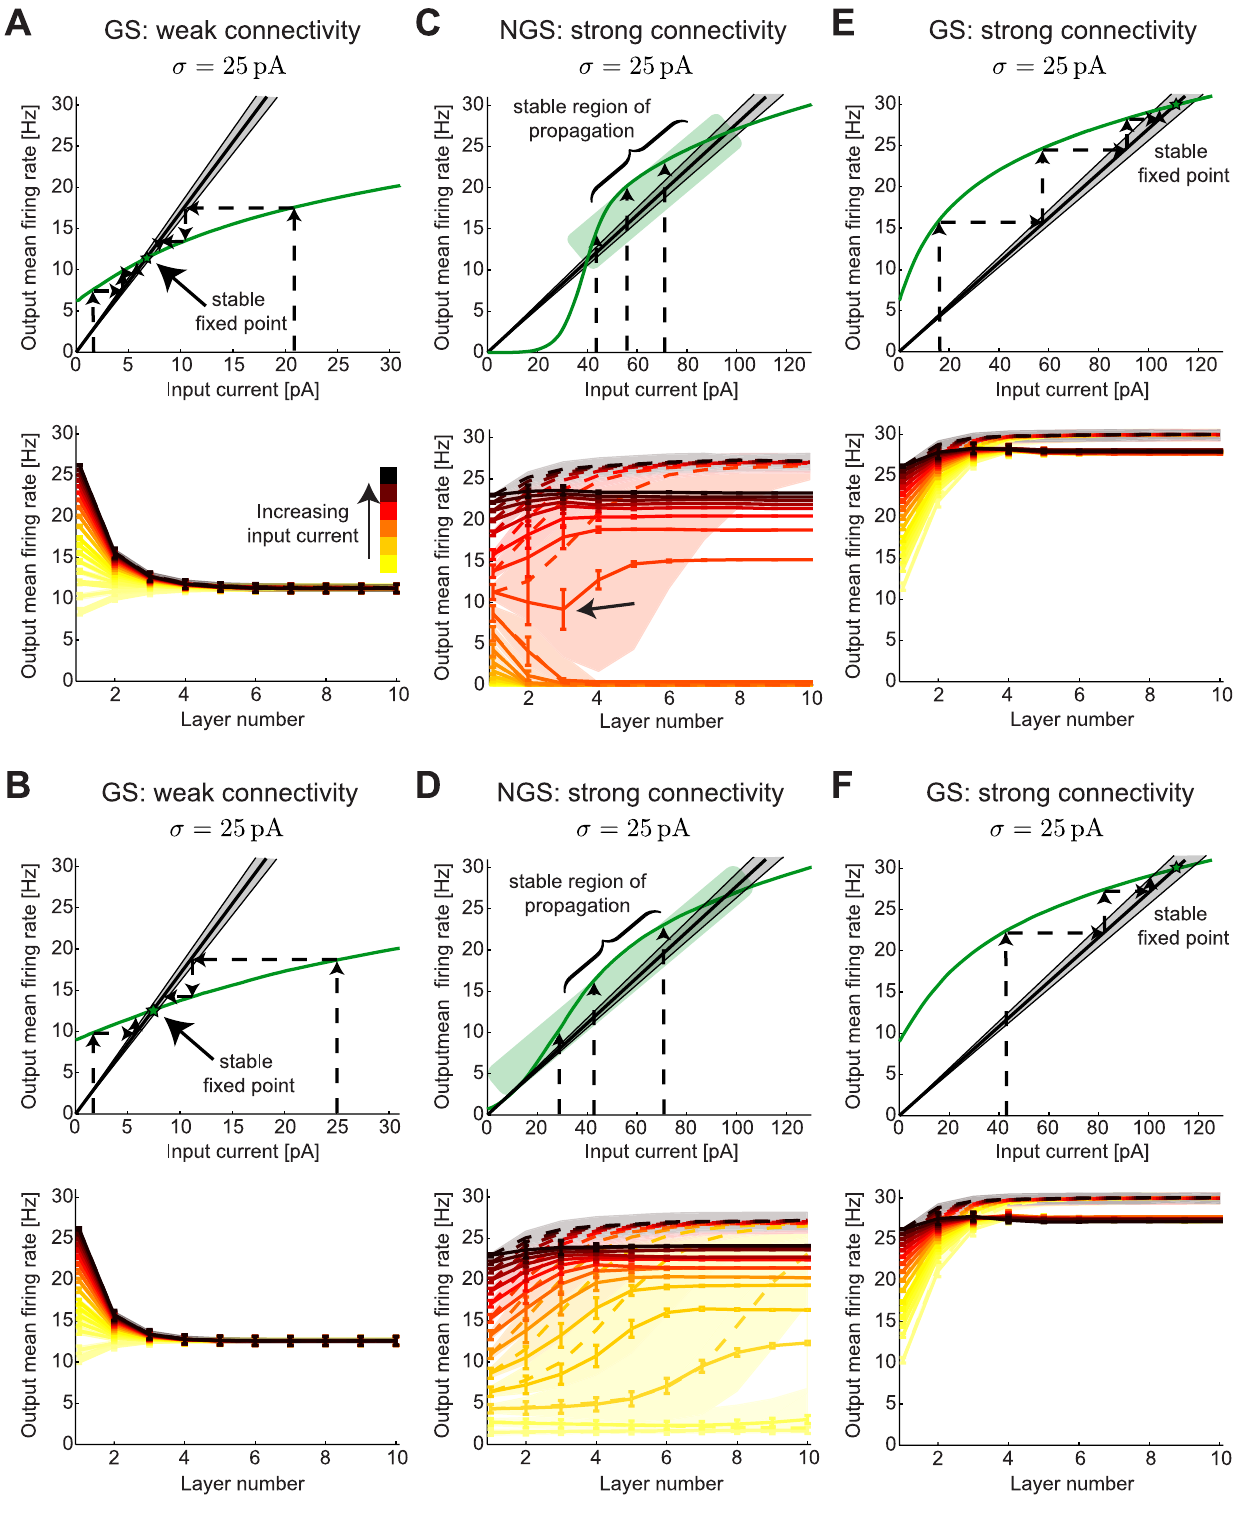
Figure 6. Firing rate propagation through networks of gain-scaling and nongain-scaling neurons. A,B. Top: The f – I curves (green) for GS neurons ( G K ~ 1000 pS/ m m 2 and G Na ~ 1500 pS/ m m 2 ) at two levels of noise, s ~ 25 pA (low noise) and s ~ 50 pA (high noise). The linear input- output relationships from the mean field (black) predict how the mean output firing rate of a given network layer can be derived from the mean input current into the first layer with the standard deviation of the prediction shown in gray. Dashed arrows show the iterated map dynamics transforming different mean input currents into a single output firing rate determined by the stable fixed point (green star). Bottom: The network mean firing rates for a range of mean input currents (to layer 1) as a function of layer number, with a clear convergence to the fixed point by layer 5.